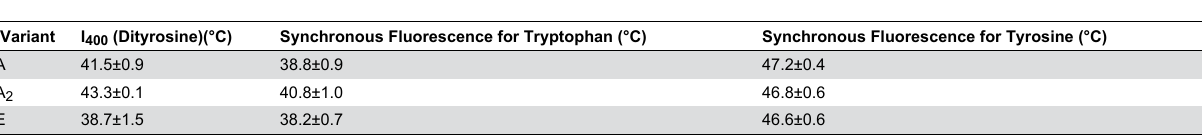
Table 2. Inflexion points from the temperature dependent Dityrosine and synchronous fluorescence measurements for HbA, HbA and HbE at pH 2